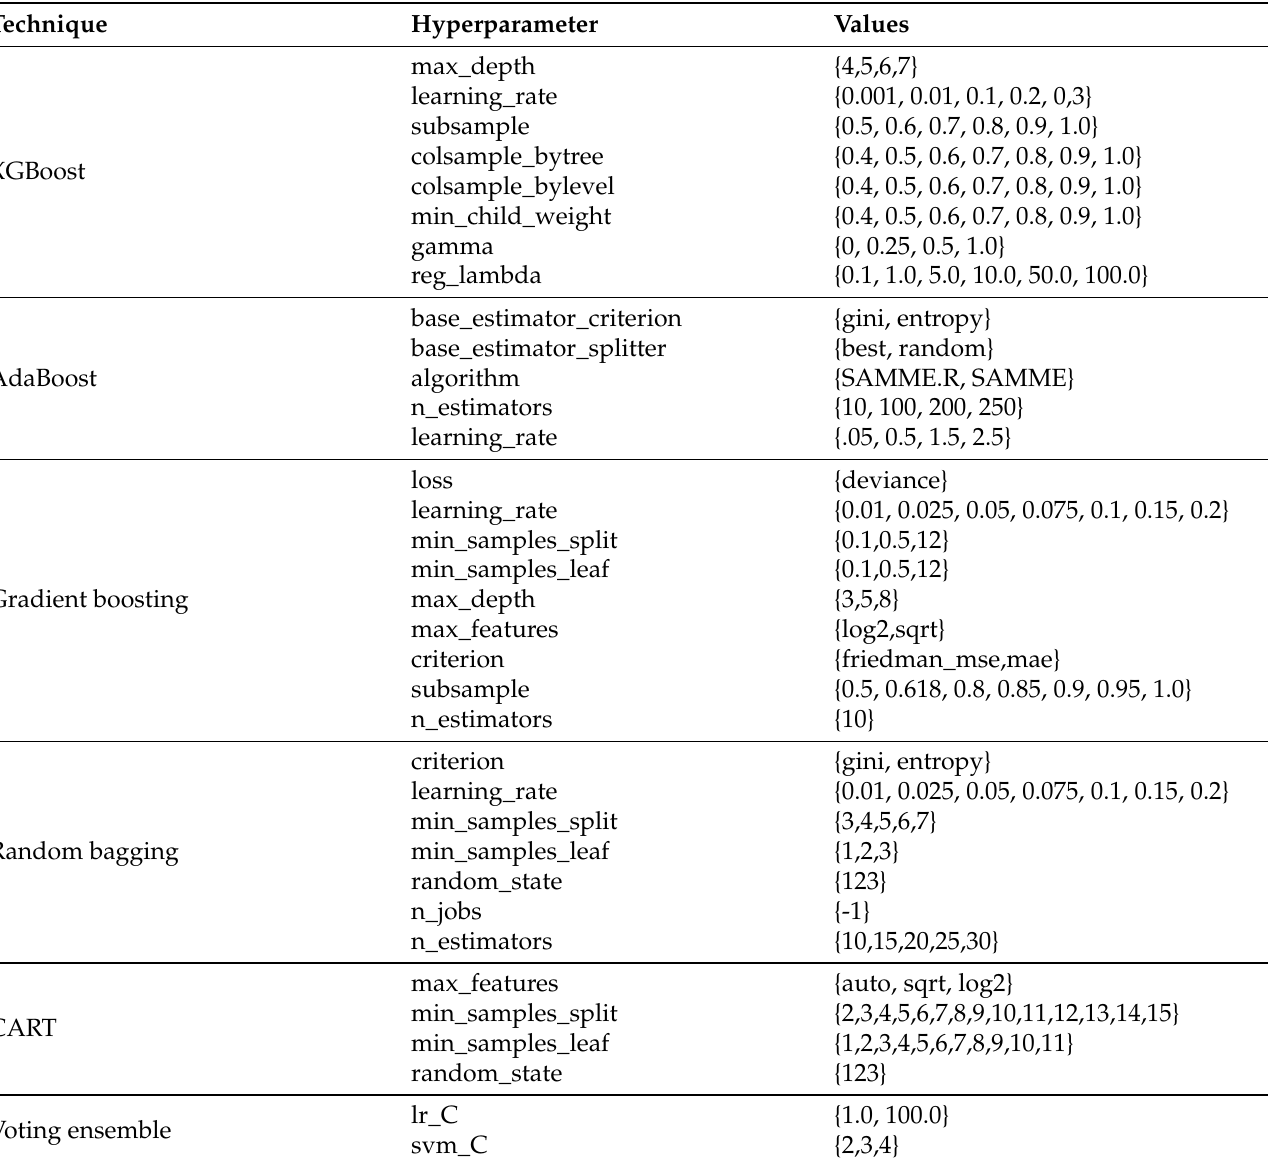
Table 3. Table 3. List of hyperparameters for each